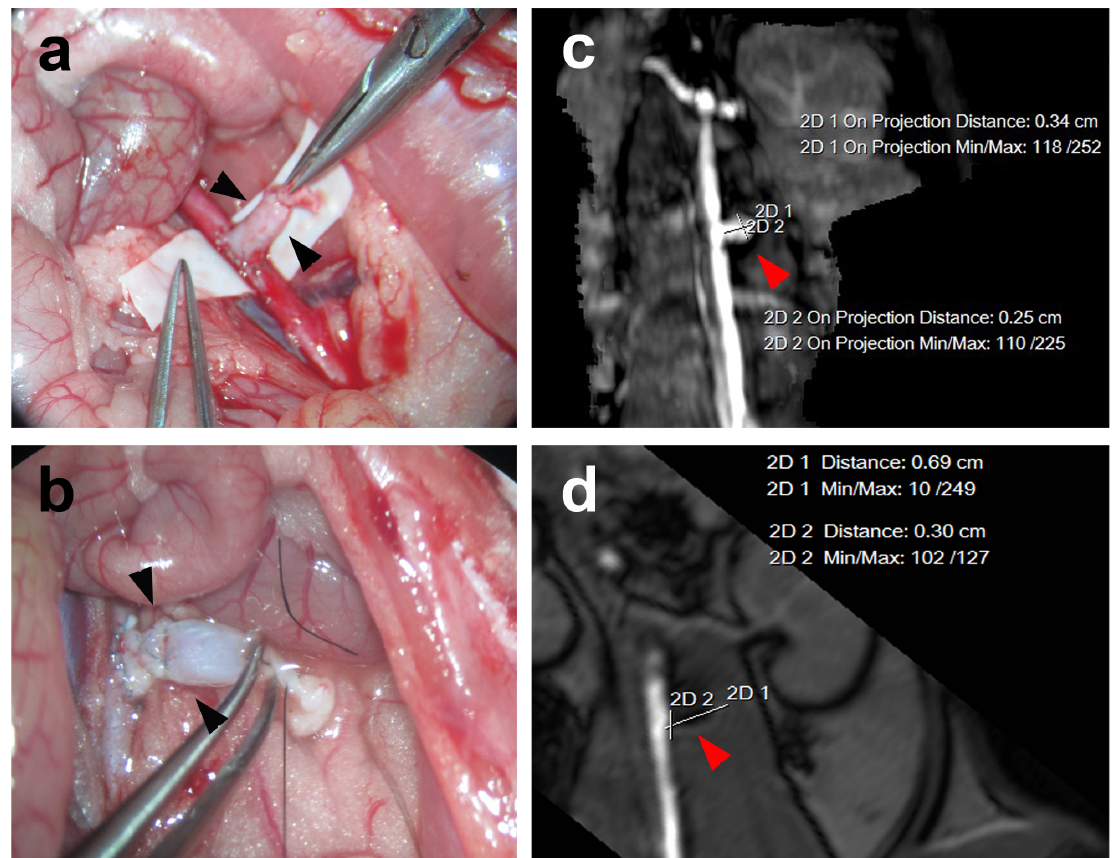
Figure 4. Animal AAA model. Rat abdominal aortic aneurysm embolization model and MRA: The arrow in the figure ( a ) shows the aneurysm without embolization and the embolism aneurysm is demonstrated by the arrow in the figures ( b ) and ( d